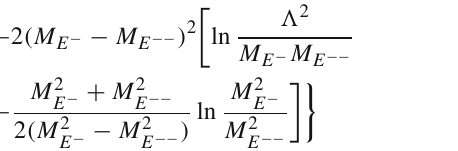
is very sensitive to even small mass splittings of the SU(2) multiplets and can result in large contributions to (cid:2)ρ in the form of W boson self energy as shown in (15). Therefore we introduce mass splitting between the excited Fermions and study its impact on the (cid:2)ρ for the doublet and triplet = M − (cid:2) M , M = M , contributions. Here we define M E − E 0 and M E −− = M + (cid:2) M .